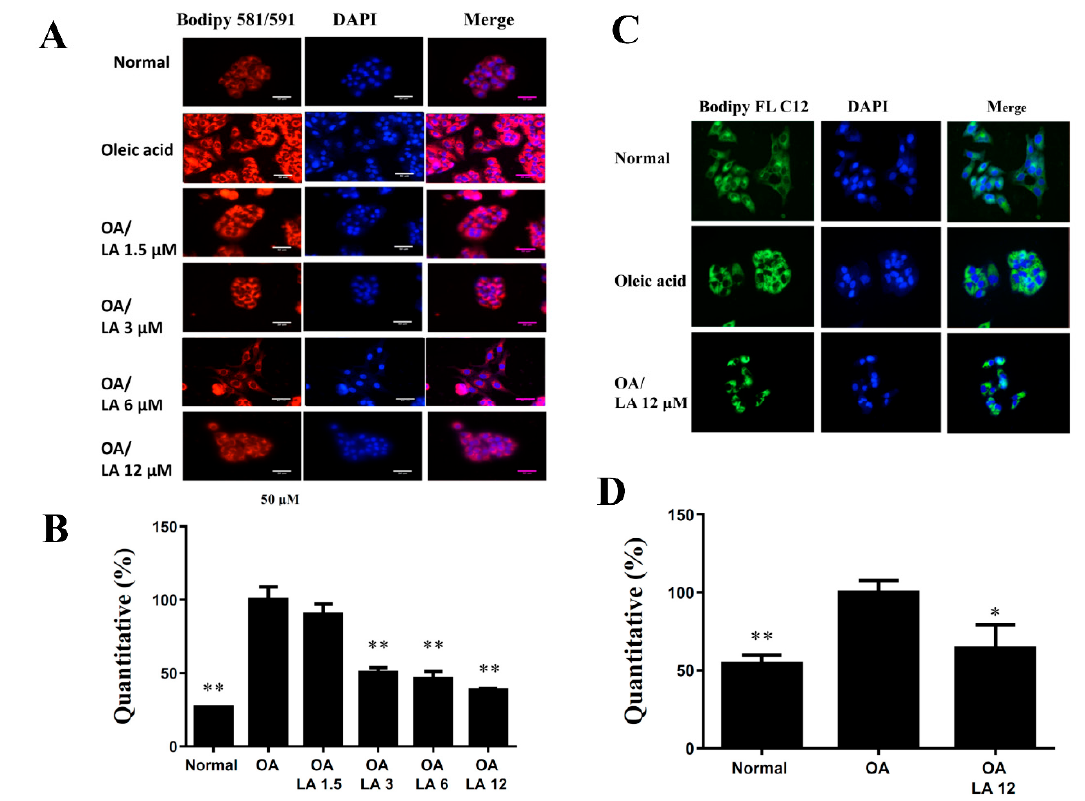
Figure 8. Licochalcone A (LA) reduced lipoperoxidation and fatty acid uptake into HepG2 cells. ( A ) HepG2 cells were treated with 0.5 mM oleic acid (OA) at 37 ◦ C for 48 h to induce lipid accumulation in hepatocytes, followed by treatment with licochalcone A (1.5–12 µ M) for 24 h. The fluorescent dye BODIPY 581 / 591 C11 (red) was used to detect hepatic lipoperoxidation under a fluorescent microscope. Three independent experiments were analyzed. Nuclei were stained with DAPI (blue). ( B ) Fluorescent images were quantified and compared with oleic acid-induced HepG2 cells. ( C ) Oleic acid-induced HepG2 cells were treated with licochalcone A for 24 h before staining with the fluorescent probe BODIPY FL C12 (green). Nuclei were stained with DAPI (blue). ( D ) Fluorescent images were quantified and data are presented as the mean ± SEM; * p < 0.05, ** p < 0.01 compared with oleic acid-induced HepG2 cells. Three independent experiments were analyzed.